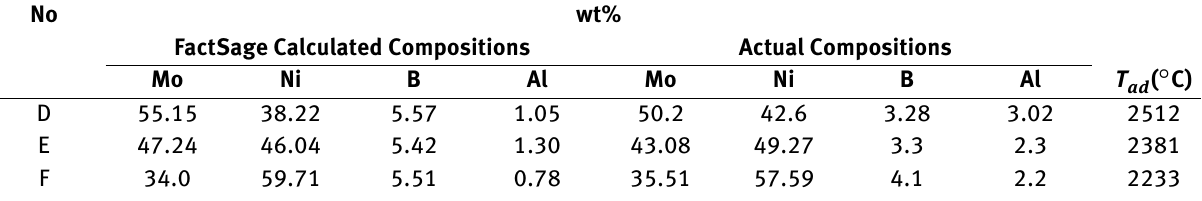
Table 4: FactSage calculated compositions and T ad values, and actual elemental compositions of the as-cast alloys from the second series of experiments.